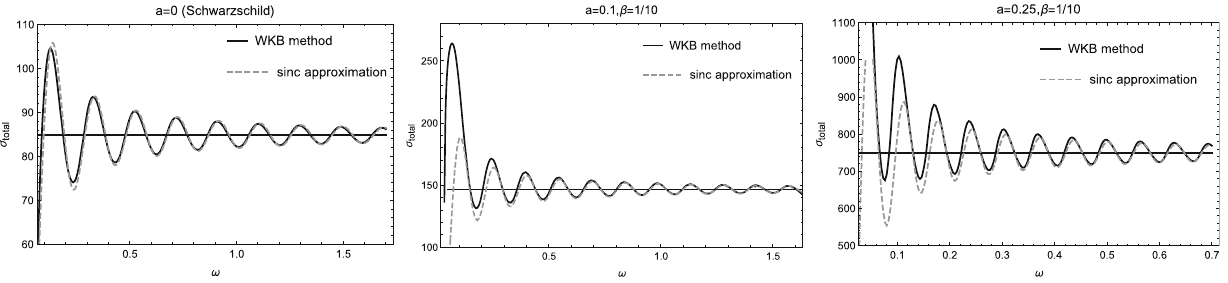
, l = 3 in the left panel and the variable β at a = 0 . 1, 10 10